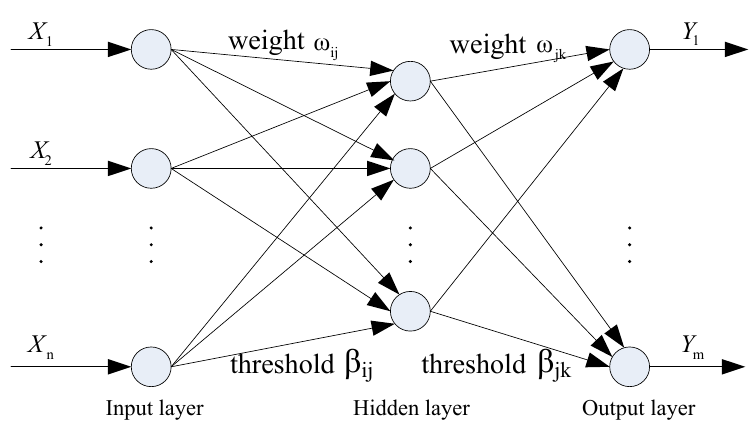
Figure 15. BP-ANN topological structure diagram.